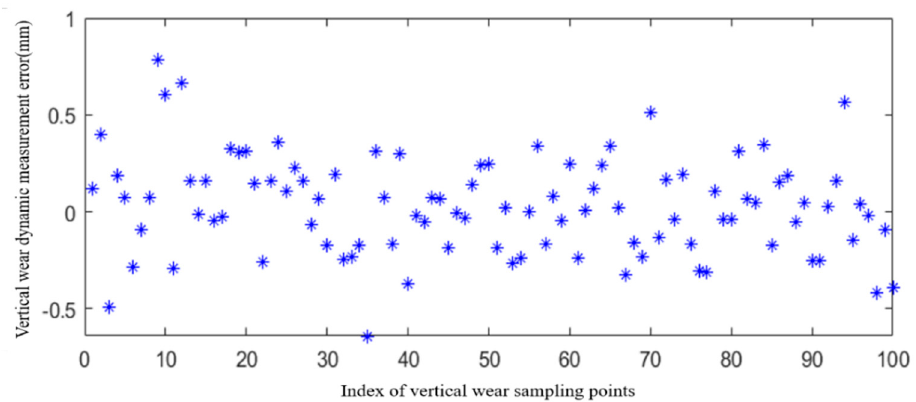
Figure 12. On-site Vertical wear measurement error.